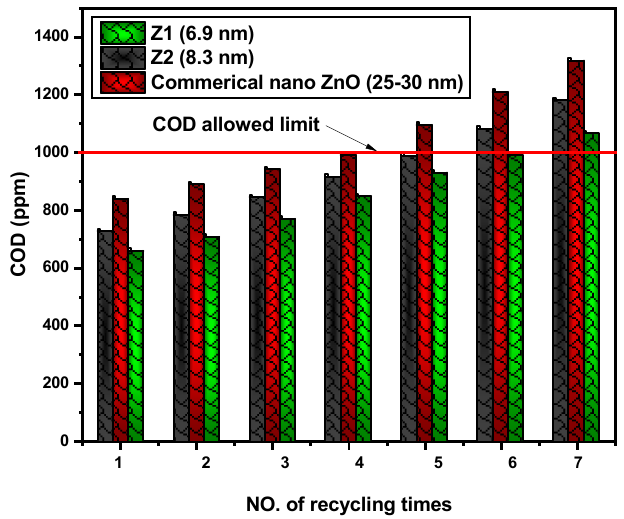
Figure 11. COD limits for the recycling process of real industrial wastewater in the presence of pre- pared ZQDs samples during photocatalysis by sunlight.